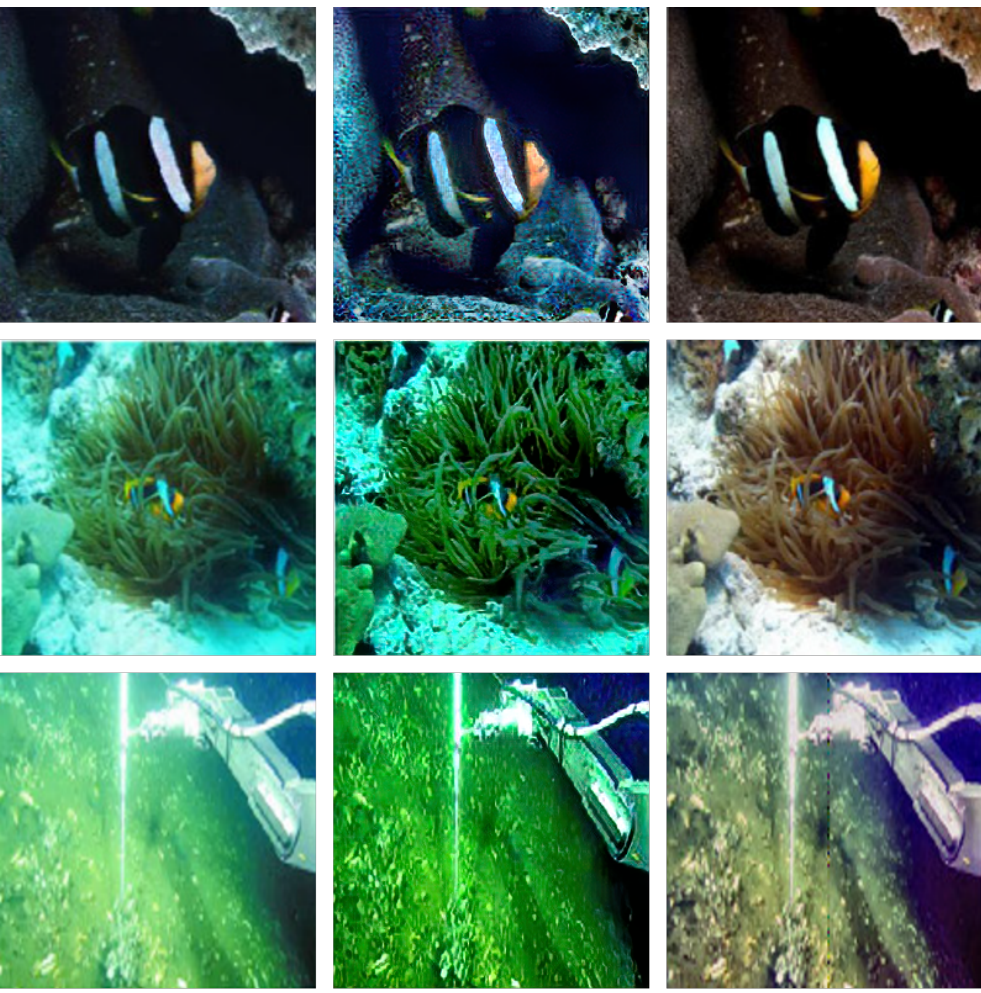
Figure 8. Visual comparison of synthetic underwater images. From left to right are raw underwater images, proposed and clean (ground-truth) images. The proposed and clean images are compared with results from Ancuti [11], Guo [36], Berman [37], Cosman [8], Zhuang [19], and gl